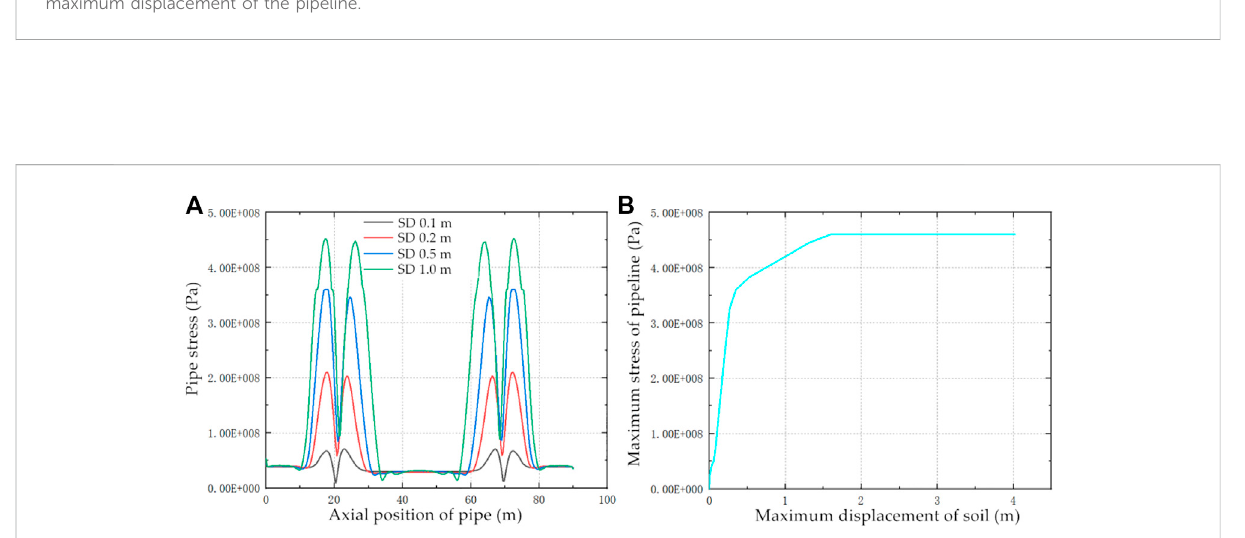
Relationship between pipeline stress and landslide soil displacement (SD): (A) stress at different positions of the pipeline, (B) maximum stress of the